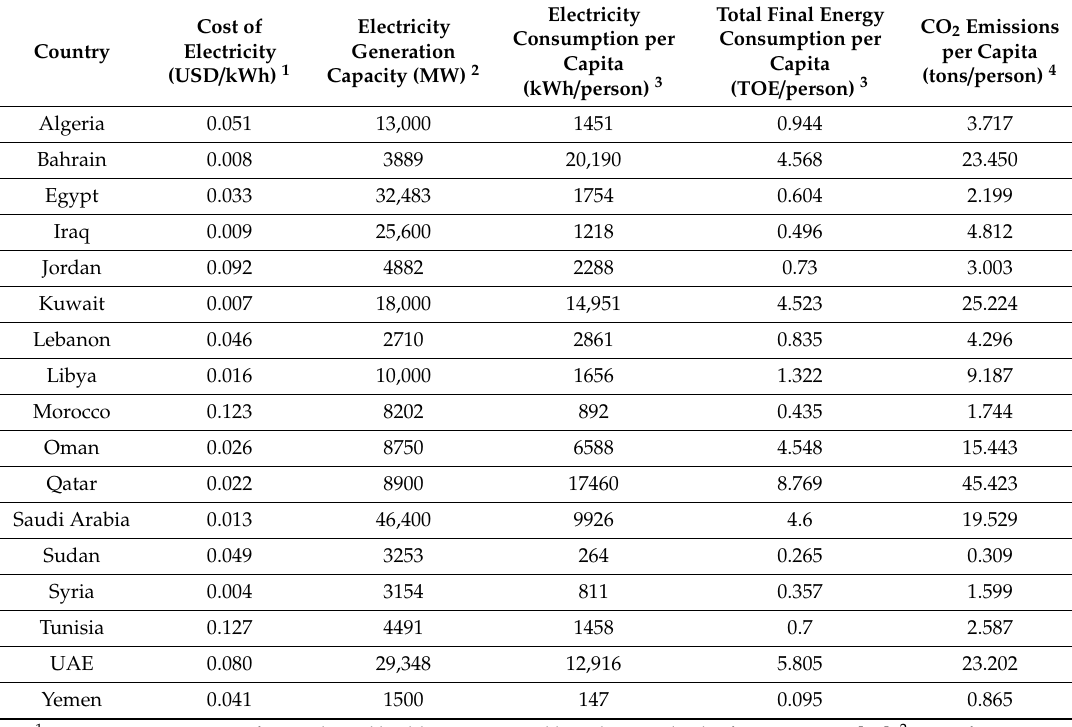
Table 8. Electricity prices, energy use, and carbon emissions indicators for Arab